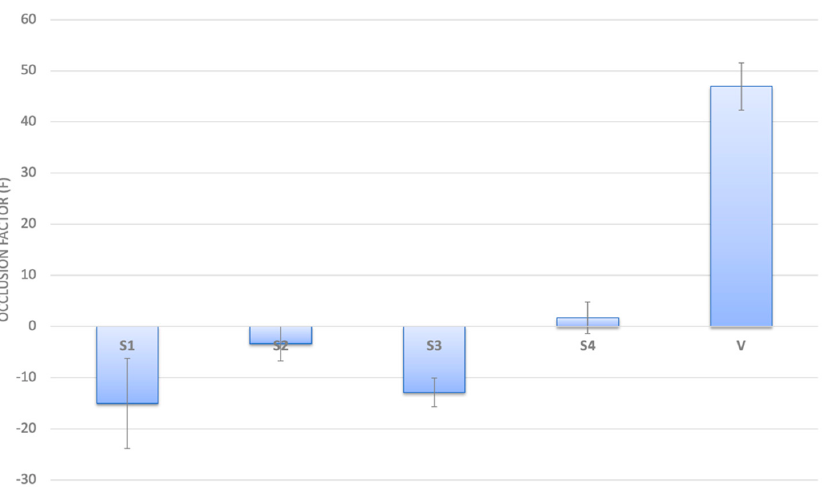
Figure 7. Occlusion Factor (F) after 24 h from application of S1 (NAC-CH-MLC at concentration of 12 mg/cm 2 ), S2 (NAC-CH-MLC at concentration of 50 mg/cm 2 ); S3 and S4 are CH-MLC samples with the same solid concentration of S1 and S2, respectively; V is the occlusive